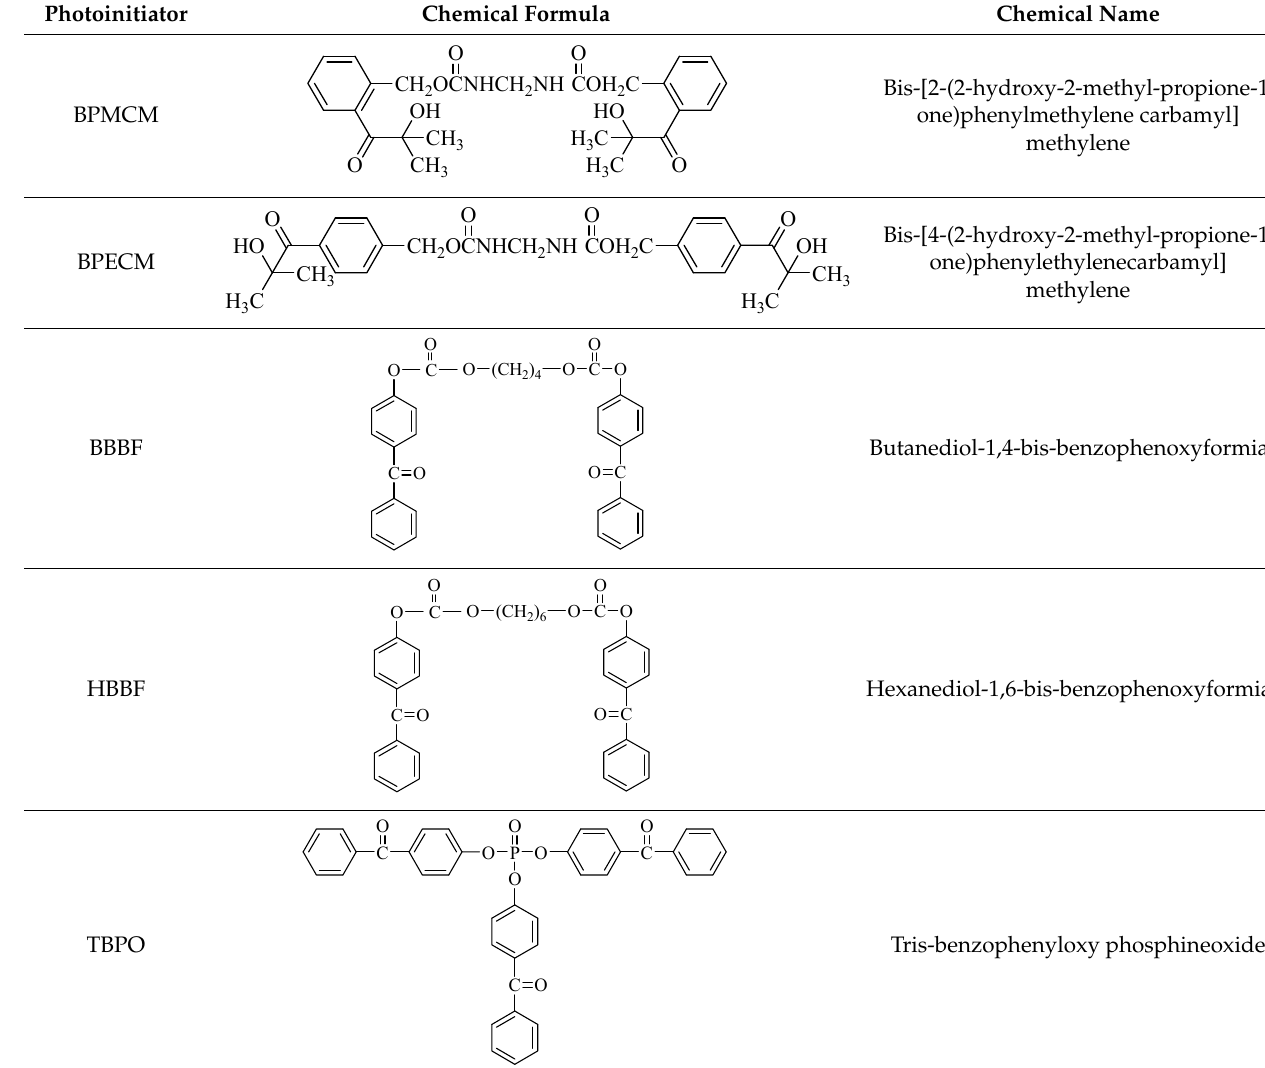
Table 1. Multifunctional photoinitiators of type I and type II used for UV-crosslinking of acrylic PSAs. Photoinitiator